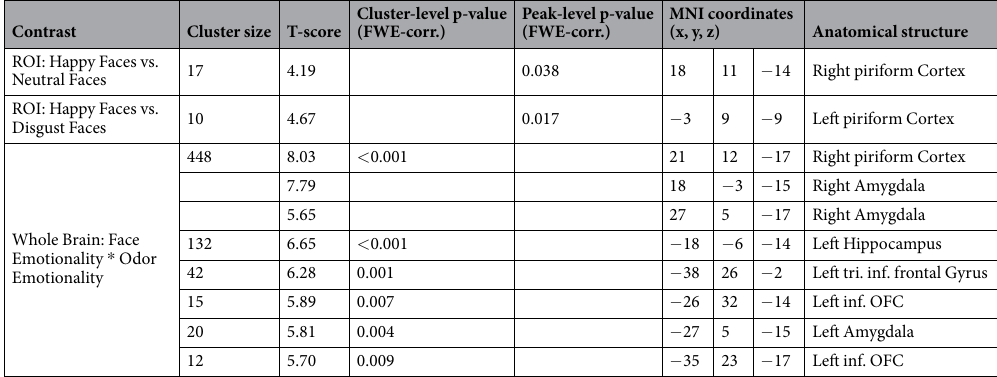
Table 1. Activation clusters of region of interest (ROI) analysis within the primary olfactory cortex (POC) for visual presentation of facial expressions without olfactory stimulation and activation clusters of the interaction effect from whole brain analysis of subsequent olfactory stimulation dependent on preceding facial expressions. Cluster size = number of contiguous voxels surviving FWE-correction; FWE-corr. = Family Wise Error corrected for multiple comparisons at threshold of 0.05; MNI coordinates = standard coordinates by the Montreal Neurological Institute; tri. = triangular; OFC = orbitofrontal cortex; inf. =